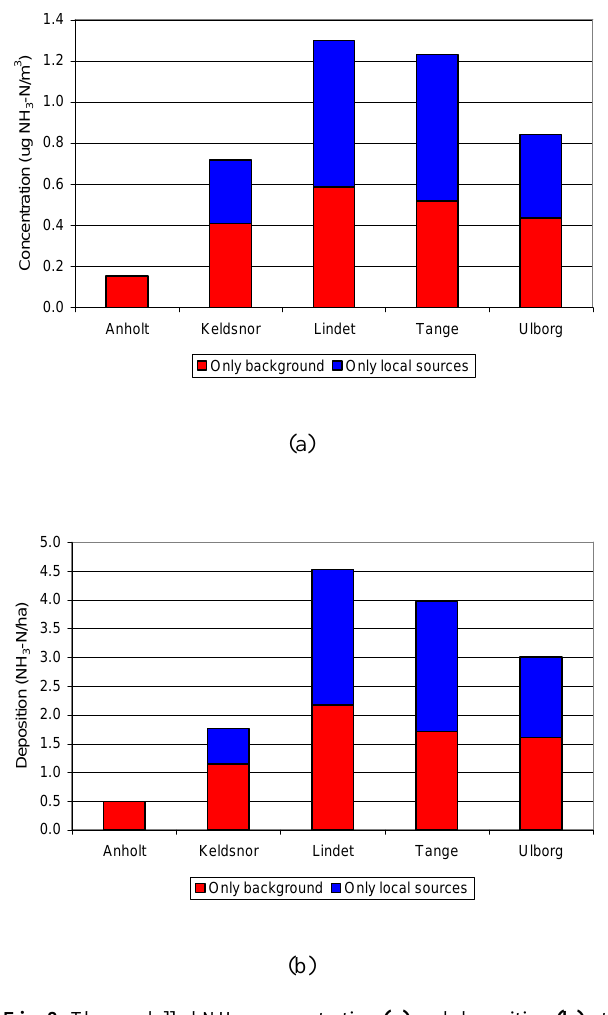
Fig. 8. The modelled NH 3 concentration (a) and deposition (b) at the five main sites separated into “only background” and “only lo- cal sources” for the year 2007. The “background” refers to the part coming from non-local sources, i.e. due to NH 3 transported into the OML-DEP domain from upwind sources in the DEHM model do- main. The “local sources” refer to the part coming from the local NH 3 emissions within the OML-DEP domain. The size of the local emissions can be seen in Fig.